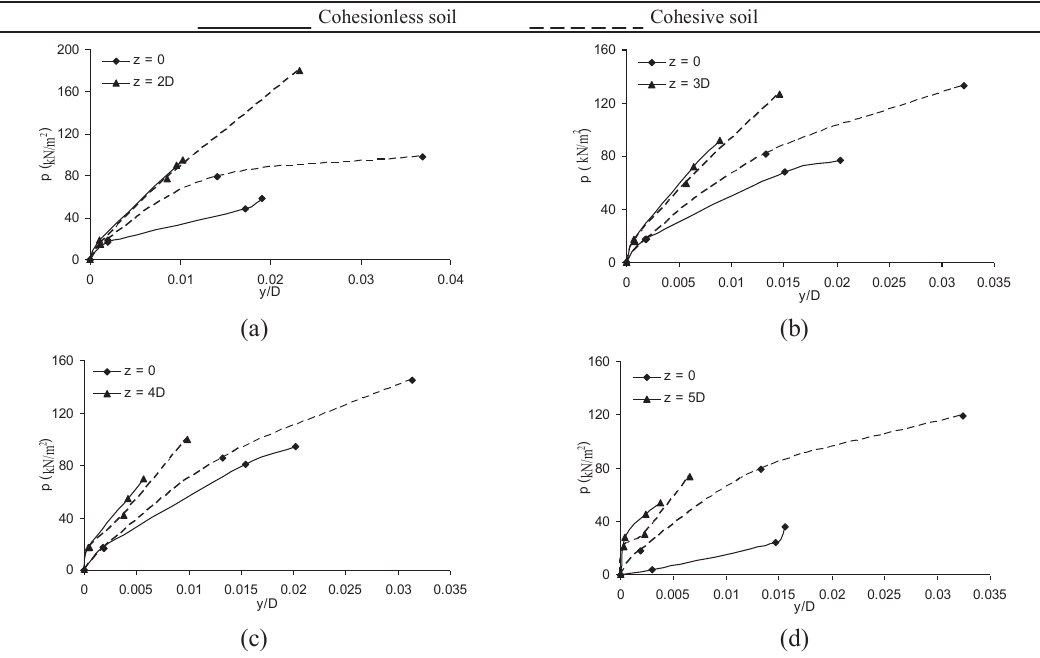
Figure 6 p-y curves predicted under the effect of lateral load intensities and pile slenderness ratio: (a) L = 10 m, (b) L = 15 m, (c) L = 20 m and (d) L = 25 m